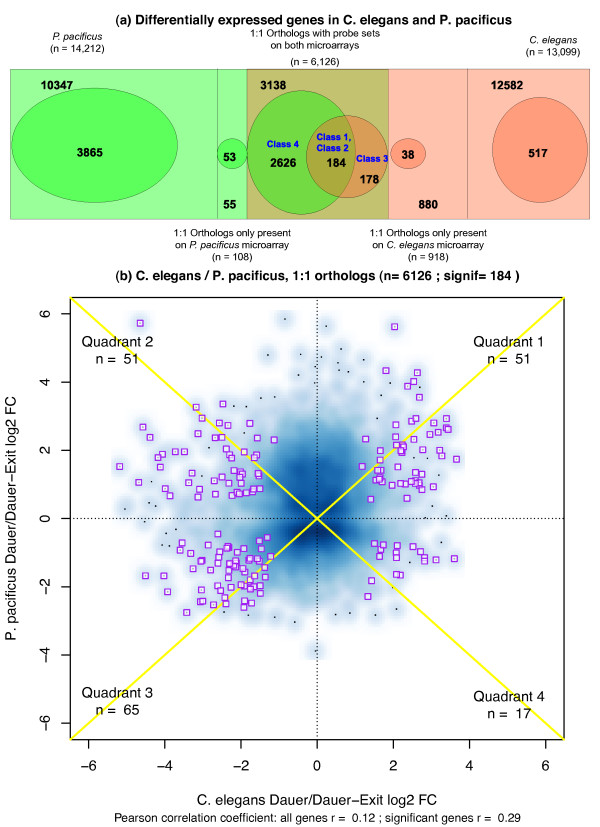
Limited conservation in the dauer related transcriptomes of the two species. (a) Overlap between genes differentially expressed in P. pacificus (green) and C. elegans dauers versus dauer-exit (12 hours) samples. The rectangular boxes represent the entire transcriptome on the array and their area of overlap represents the 1:1 orthologs between the two species, which are represented on both microarrays. The ovals represent the set of differentially expressed genes in each species. 184 orthologous gene pairs are called significantly differentially expressed in both the species, indicating limited conservation (Fisher's exact test p-value = 0.029). A substantial number of non-orthologous, species-specific genes are also differentially expressed in both the species. These gene sets are further analyzed by dividing them into distinct classes which are indicated in blue text (see main text for details) (b) Comparison of log2 expression fold changes for the set of 6,126 1:1 orthologs for the dauer versus dauer-exit comparison. Pearson's correlation coefficient over the entire set of 6,126 orthologs is r = 0.12, and increases to r = 0.29 for the 184 orthologs, which are significantly differentially expressed in both species (FDR corrected p-value < =0 0.05; purple boxes mark the significant orthologs, number per quadrant I - IV: 51 + 51 + 65 + 17 = 184).